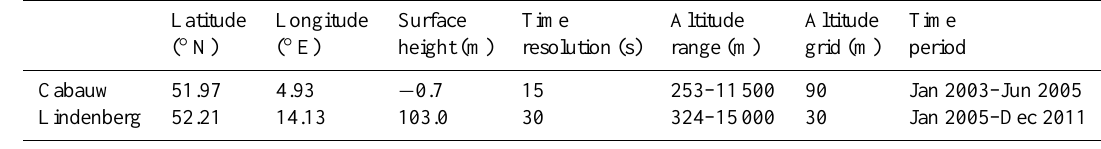
Table 1. Information on the Cloudnet target classification product at Cabauw and Lindenberg.